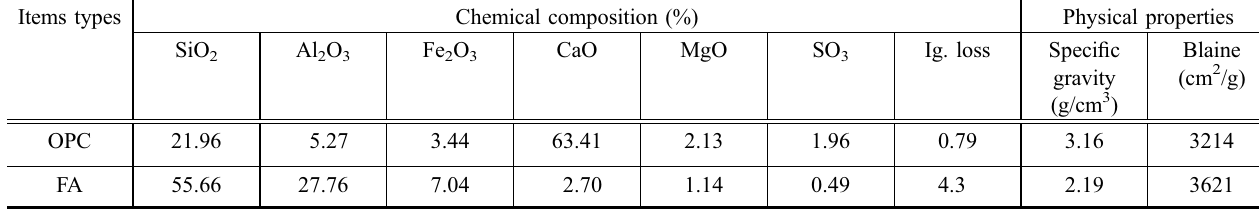
Table 2 Physical and chemical properties of the cement and FA